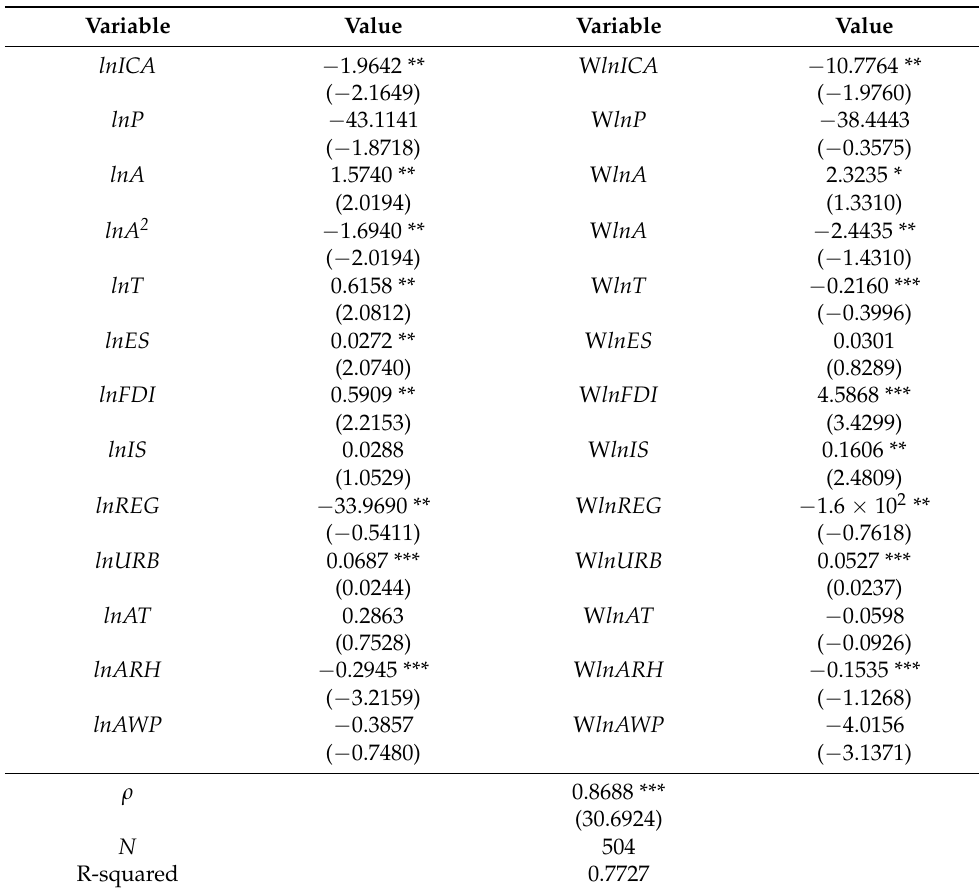
Table 6. Robustness